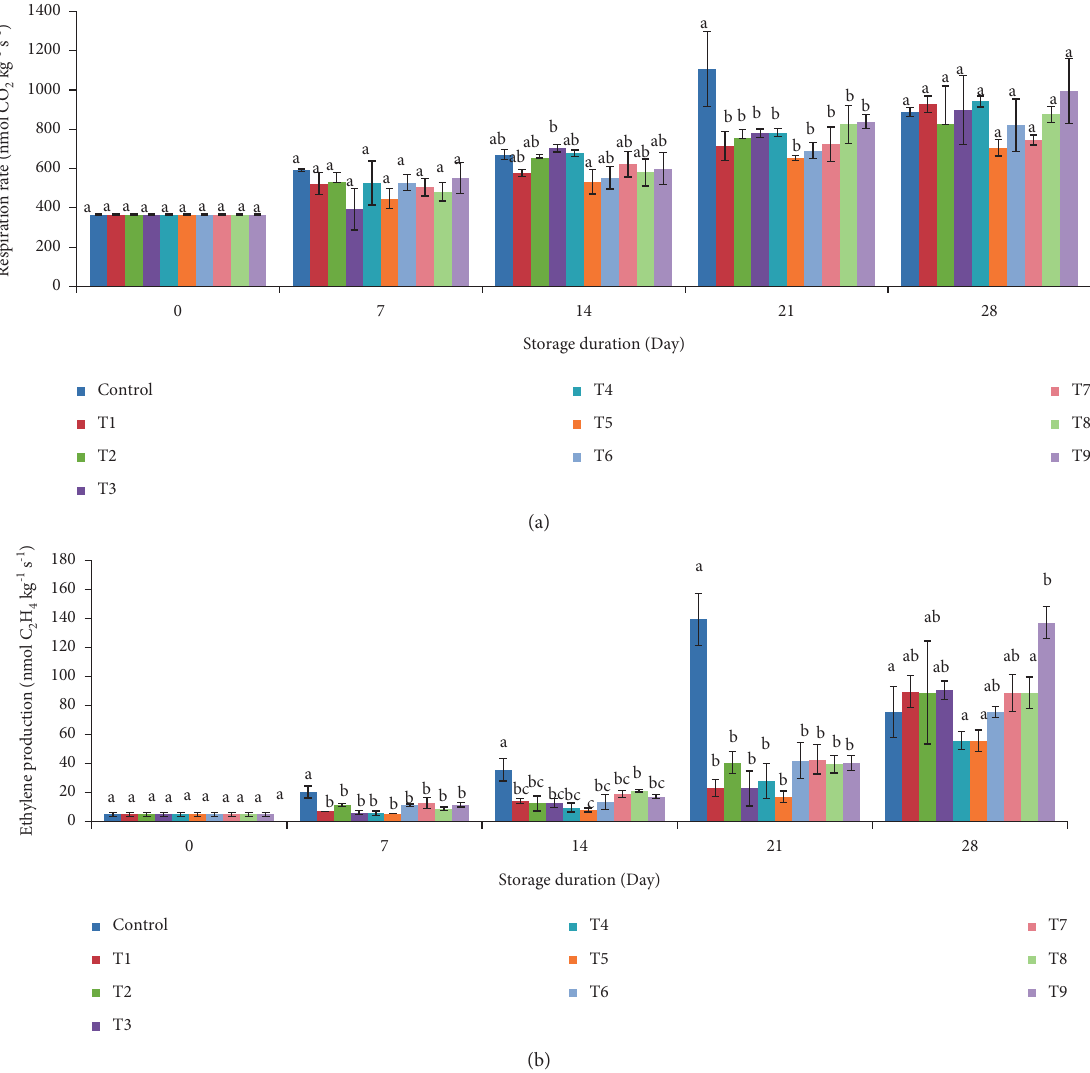
Figure 2: (a) Respiration rate and (b) ethylene production of mango cv. “Dashehari” treated with melatonin (MT), followed by low- temperature storage at 5 ± 1 ° C. Measurements were taken every 7 d of storage, followed by a 3d of shelf life at room temperature. Each value is the mean of three replicates; vertical bars indicate the standard error. Different lowercase letters on the same storage period indicate a significant difference ( p < 0 . 05) according to Duncan’s multiple range test. The abbreviated treatment details: 0 (control), 50 µ M for 90min (T1), 50 µ M for 120 min (T2), 50 µ M for 150 min (T3), 100 µ M for 90 min (T4), 100 µ M for 120min (T5), 100 µ M for 150min (T6), 150 µ M for 90min (T7), 150 µ M for 120min (T8), and 150 µ M for 150min